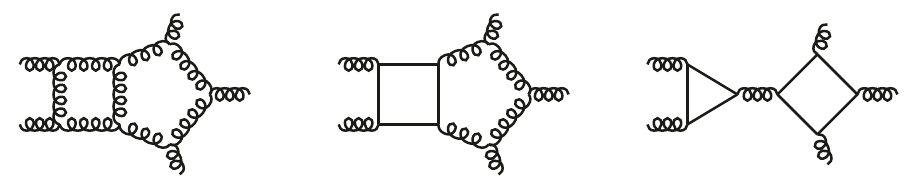
Figure 3 . Representative Feynman diagrams for leading-color A (2) ( g; g; g; g; g ) amplitudes, con- tributing at order N 0